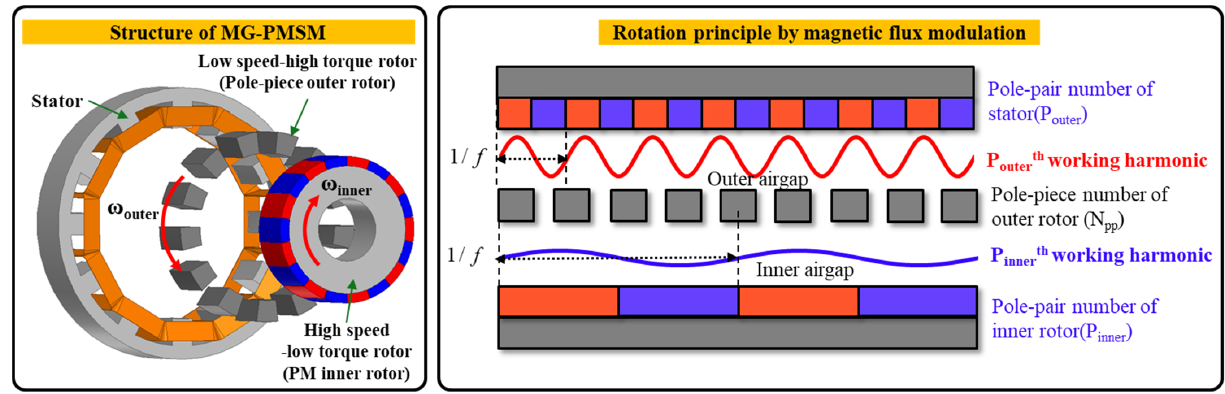
Figure 2. Structure of MG ‐ PMSM and rotation principle by magnetic flux modulation in double air gap of MG ‐ PMSM.